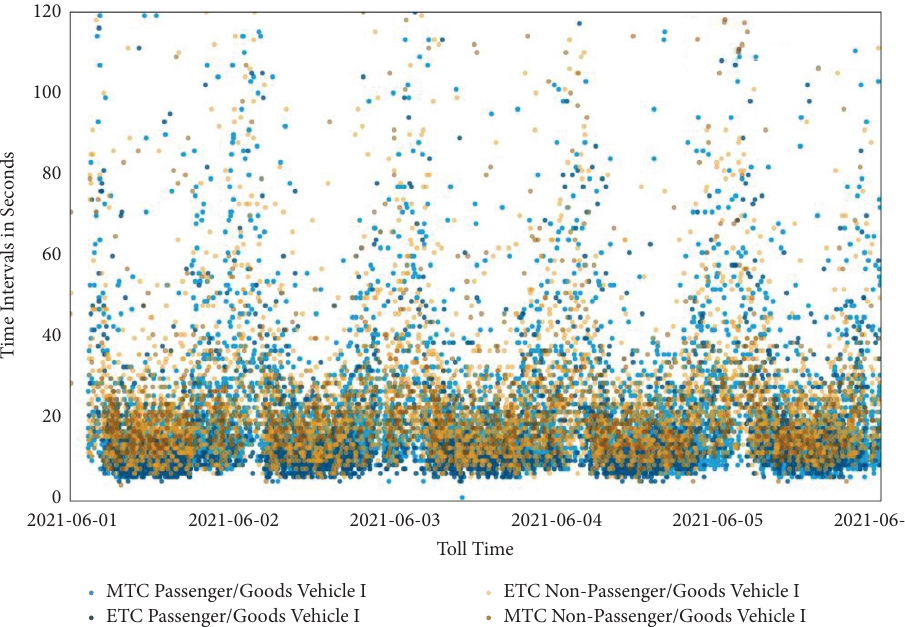
Figure 6: Scattergrams of time intervals of ETC/MTC compound entrance lane 15# at No. 6706 toll